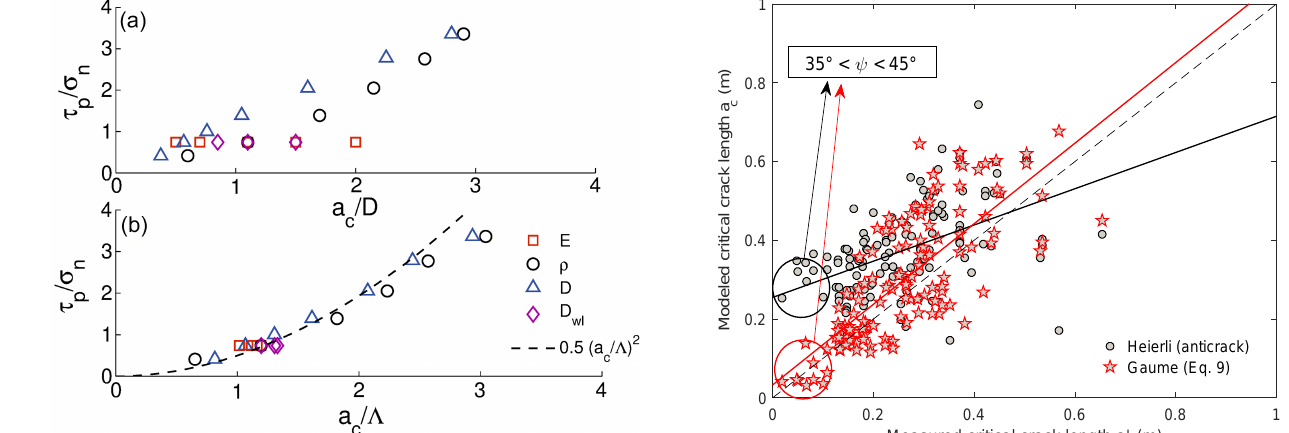
Figure 6. Comparison between measured and modeled critical crack lengths using the anticrack model (Heierli et al., 2008) (black circles) and our new model (Eq. 9, red stars). The continuous lines represent linear fits, both highly significant with p < 0.01; in black, a c = γ H a (cid:48) c + δ H with γ H = 0 . 46 (0.32, 0.61), δ H = 0 . 23 (0.21, (cid:48) = 0 . 24; in red, a c = γ 0.30), and R 2 c + δ G with γ G = 1 . 023 G a H = 0 . 58. The num- (0.872, 1.173), δ G = 0 . 03 ( − 0.01, 0.07), and R 2 G bers in brackets represent the 95% confidence interval. The dashed line represents the 1 : 1